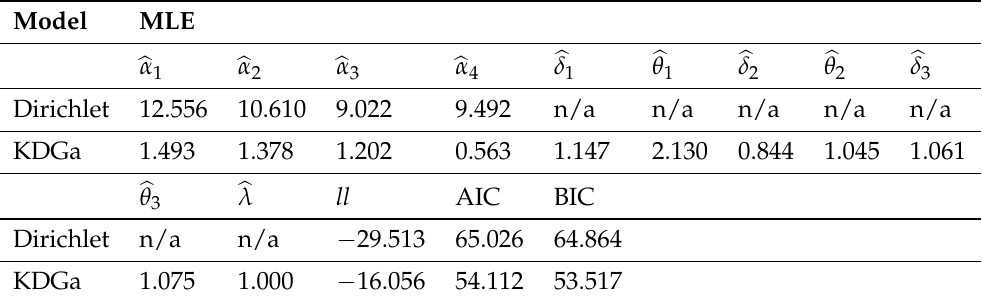
Table 3. Parameter estimates and performance analysis for the mice Morris water maze behavior data